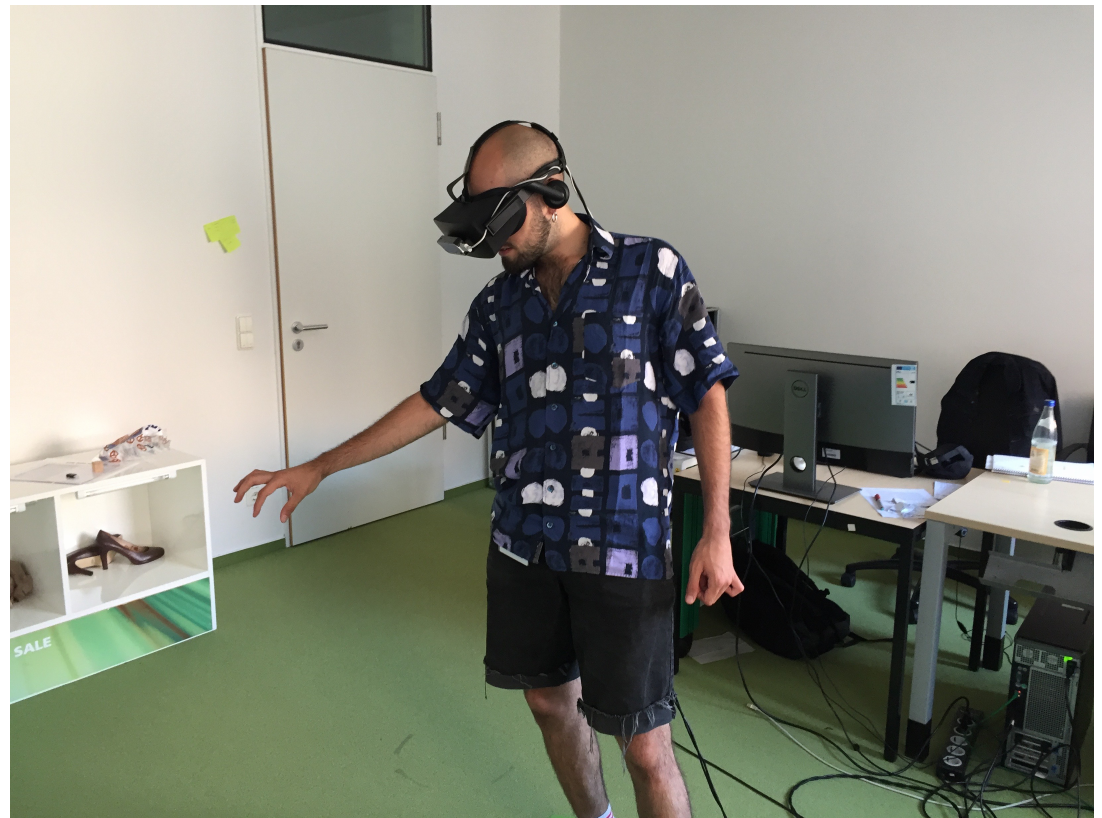
Figure 4. Participant engaging in task (front view of one of the Leap Motion